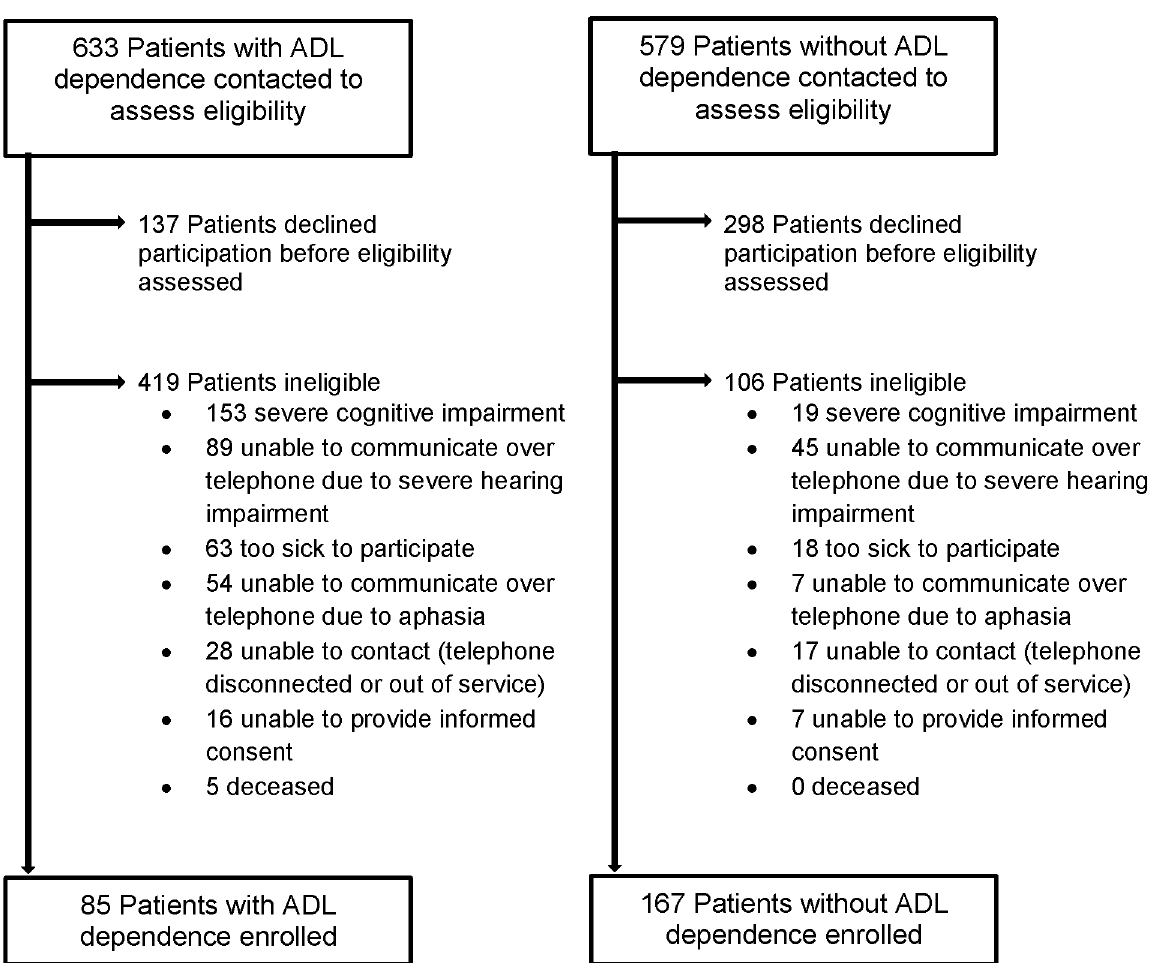
Fig 1. Flow-chart of recruitment of 252 older adults, stratified by ADL dependence. The figure shows the number of individuals with and without ADL dependence who were contacted, assessedfor eligibility,and enrolledin the study. Valuesrepresent the number of individuals in each group. ADL dependence definedas needing help to perform 1 or more activitiesof daily living, as documentedin VA